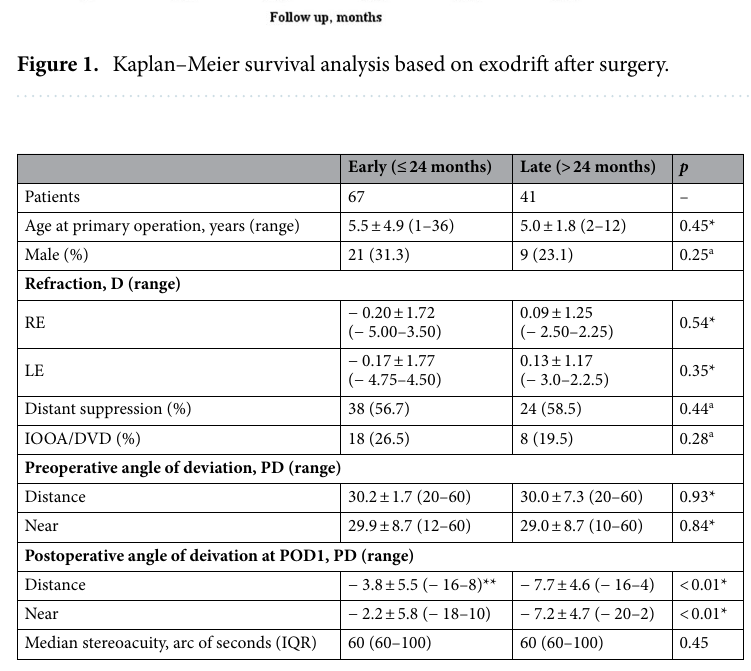
Table 3. Comparison of clinical characteristics between subgroups. D diopters (calculated as spherical equivalent), RE right eye, LE left eye, IOOA inferiorobliqueoveraction, DVD dissociated vertical deviation, PD prism diopters, POD postoperative day, IQR interquatile range. *Mann–whitney test, **minus value means esodeviation. a Chi-square